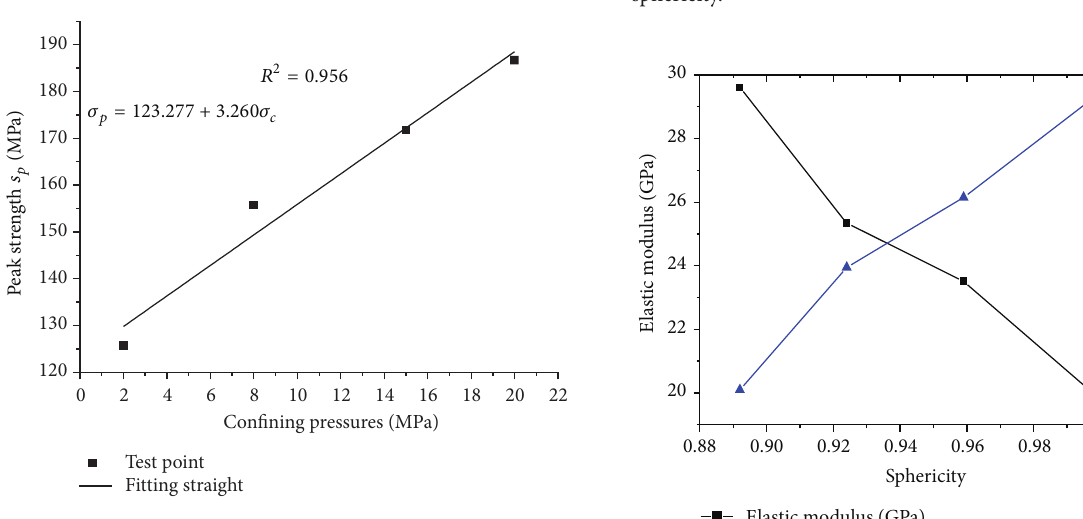
Figure 12: The peak strength versus confining pressure for sample 1.